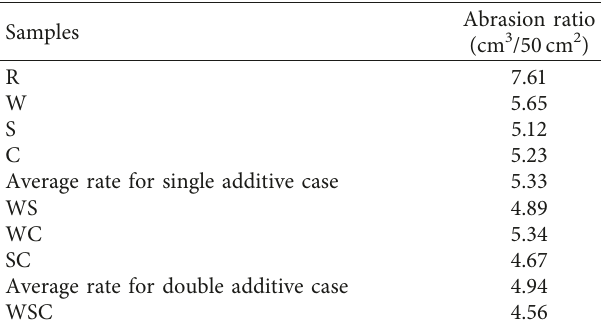
Figure 6: Compressive strengths of the samples kept in NaCl solution. Table 7: Abrasion test